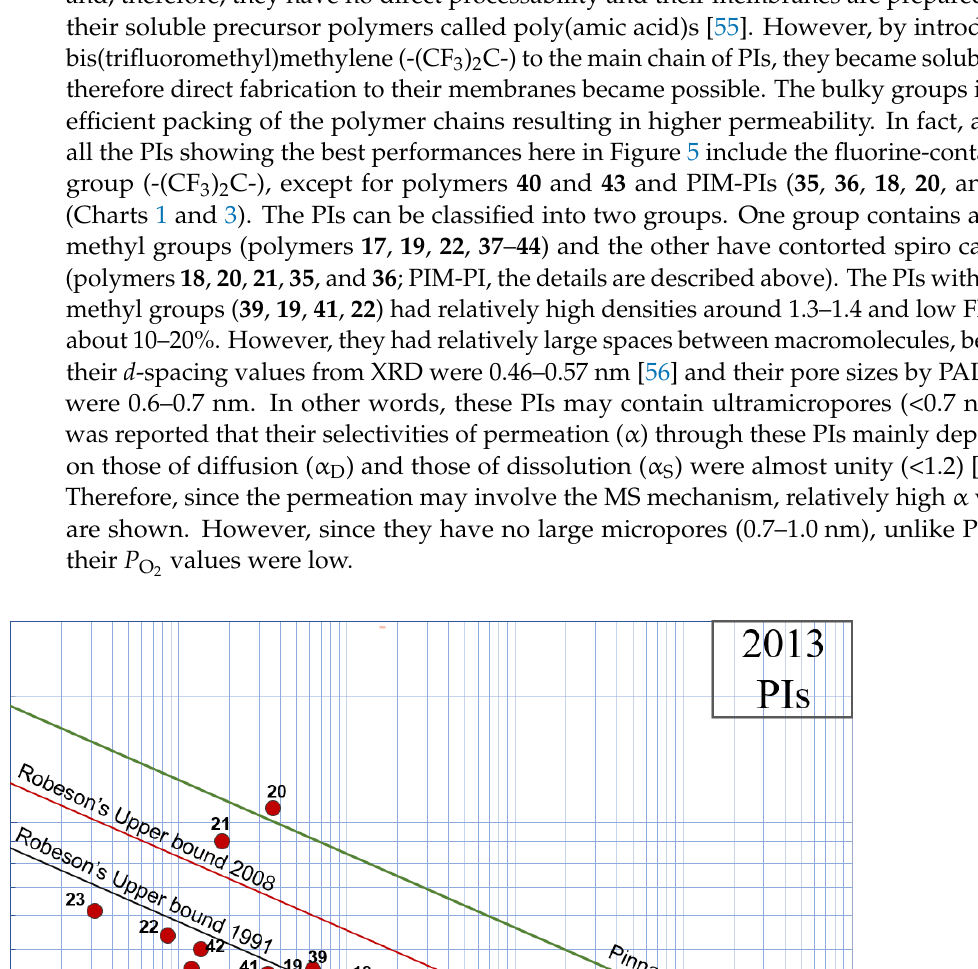
reported in the 2